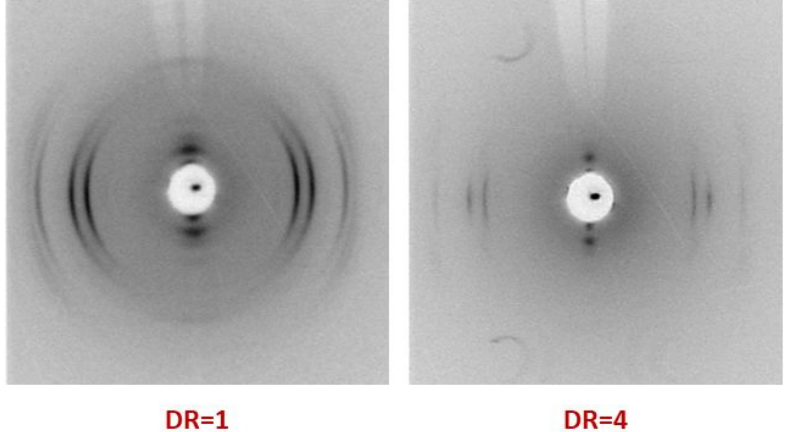
Figure 5. WAXS diffraction patterns of the crystallized R-BAPB fibers before and after orientational drawing (the fiber axis was vertical).